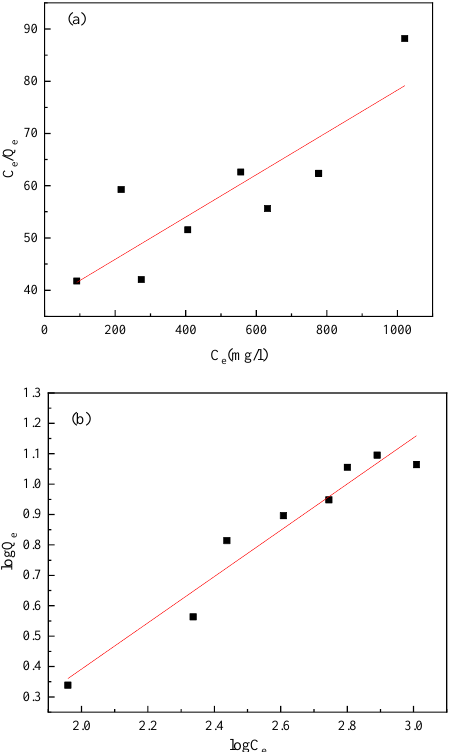
Figure 5. Fitting results of the isotherm equations for thiourea’s adsorption on pyrite: ( a ) Langmuir isotherm equation and ( b ) Freundlich isotherm equation. Table 1. Fitting results of the isotherm equations for thiourea’s adsorption on mica and pyrite. Minerals